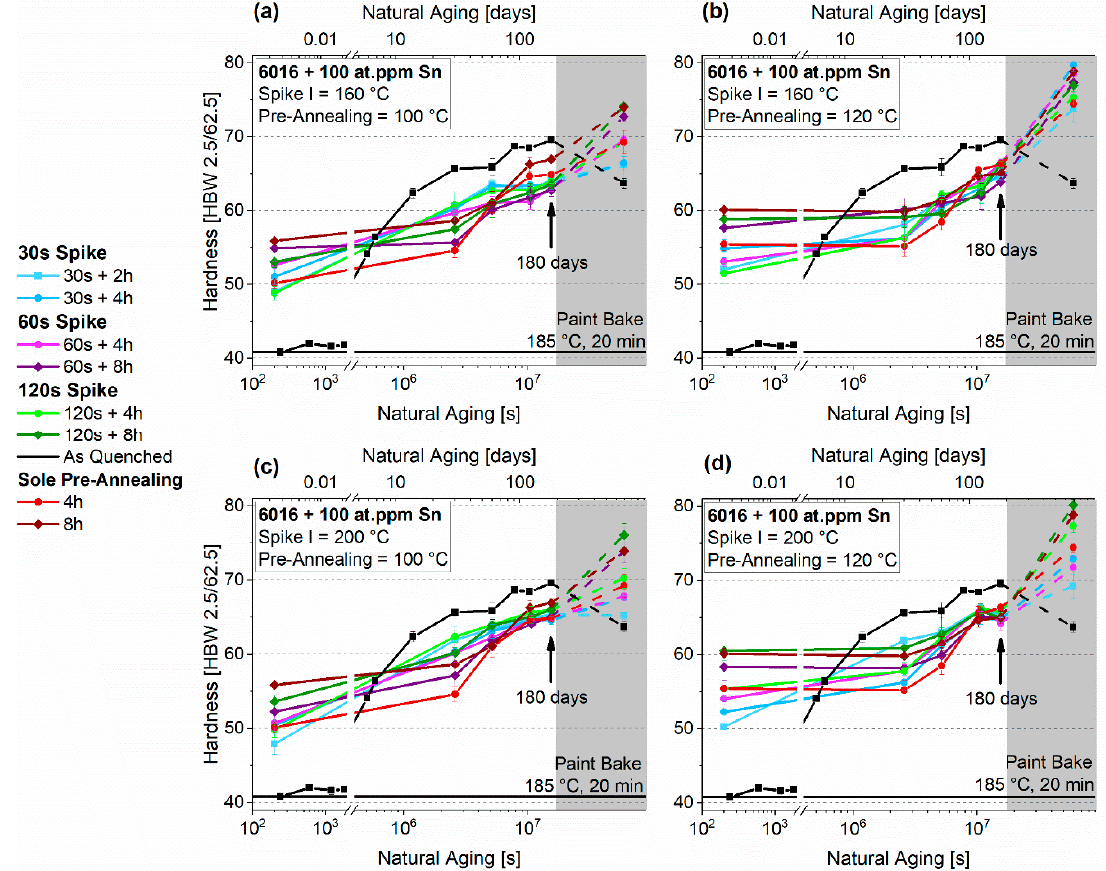
Figure 7. Natural aging behavior of samples treated according to PA2 for EN-AW-6016 + 100 at.-ppm Sn. Spike I 160 ◦ C + PA 100 ◦ C ( a ), Spike I 160 ◦ C + PA 120 ◦ C ( b ), Spike I 200 ◦ C + PA 100 ◦ C ( c ), Spike I 200 ◦ C + PA 120 ◦ C ( d ). The values from PA1 without Spike I are also depicted in red. The shaded areas show the hardness evolution during the paint-bake treatment (185 ◦ C, 20 min, no pre- deformation).